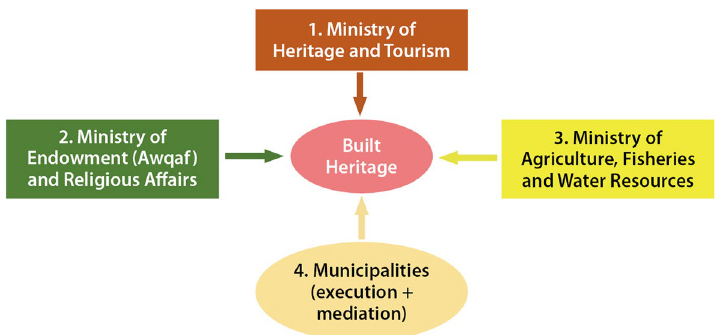
Fig. 2 The bodies managing built heritage in Oman (Source: The author based on Royal Decree 75/